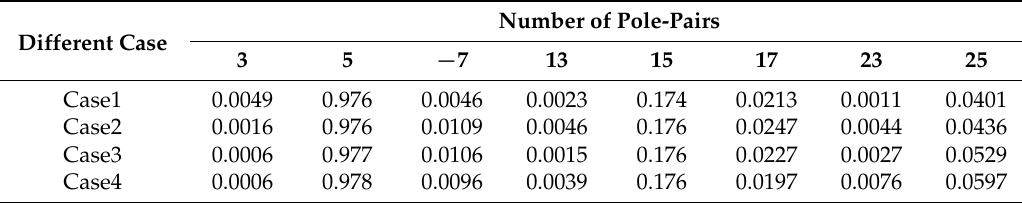
Table 6. The amplitude of the radial magnetic field by the permanent magnet in the air gap (unit: T). Different Case